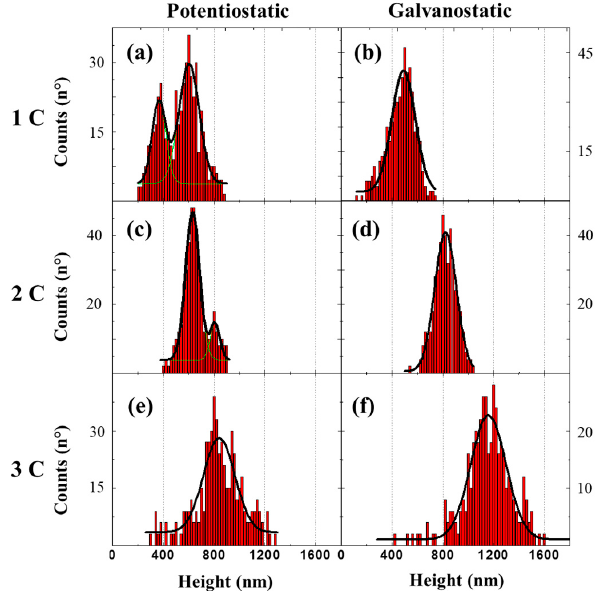
Figure 2. Histogram plots of the respective height distribution of all Ni-Npillars samples for both fabrication techniques as a function of the electrical charge. Potentiostatic at: ( a ) 1 C, ( c ) 2 C, and ( e ) 3 C. Galvanostatic at: ( b ) 1 C, ( d ) 2 C, and ( f ) 3 C. Galvanostatic at: ( b ) 1 C, ( d ) 2 C, and ( f ) 3